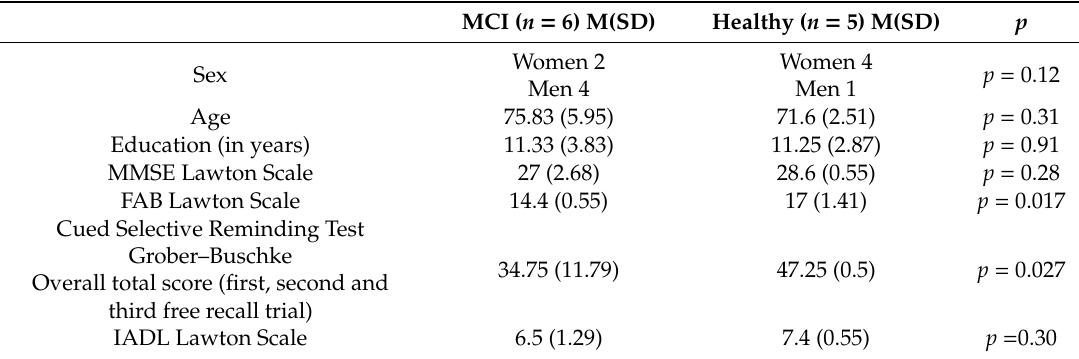
Table 1. Demographic characteristics of Nice pilot’s participants.